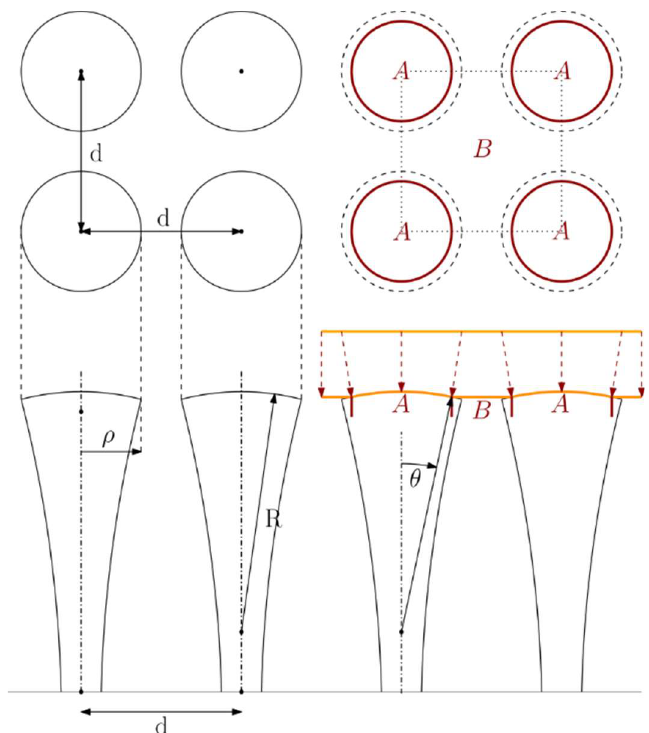
Figure 3. Schematic of the surface topology with modeling parameters. Figure (top) shows a representative arrangement of uniformly spaced nanopillars on a surface with a center-to-center distance d. Below is the side-view of the pillars showing the geometry of the pillar cap. R is the radius of curvature of the pillar cap, ρ is the pillar radius, θ is the wetting angle, A denotes the adhered region of the cell envelope, and B denotes the suspended region of the cell envelope. Red dashed arrows show the displacement of the cell envelope upon adherence to the pillar cap.